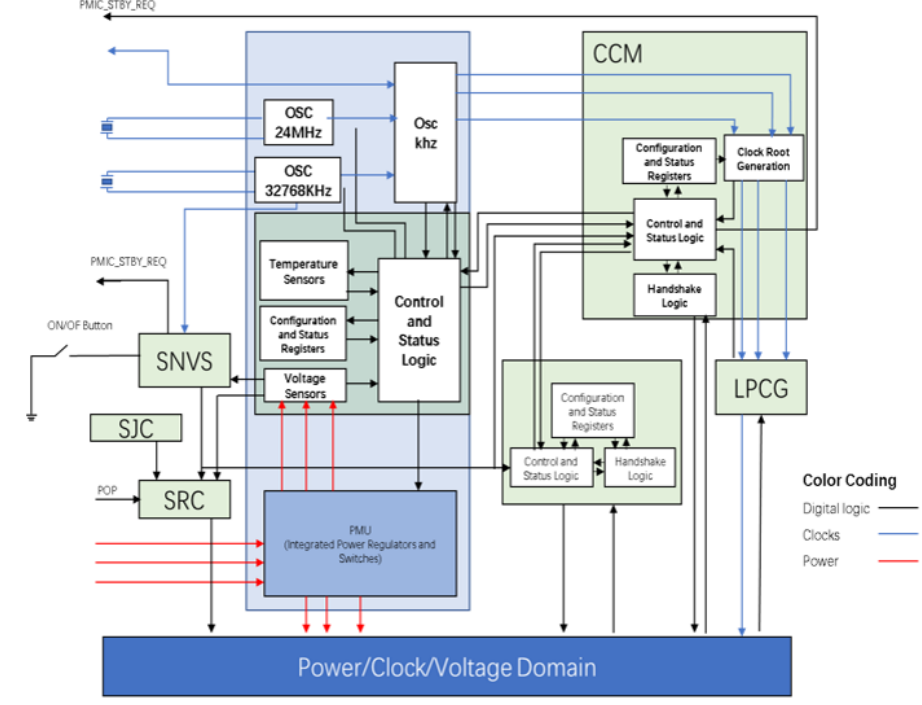
Figure 1: Power, clock, and voltage domain layout of the SMART phone application controller. Interfacing, data processing, and communication codes will be provided upon